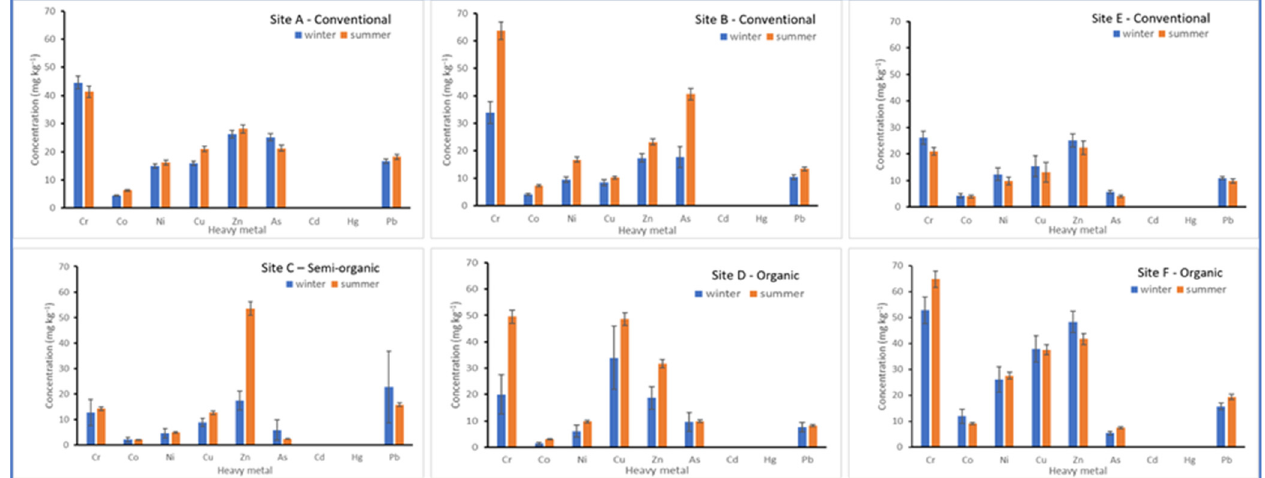
Figure 2. Seasonal fluctuation of heavy metals in soil samples from different grapevine sites ( A – F ) in the Cape Winelands.